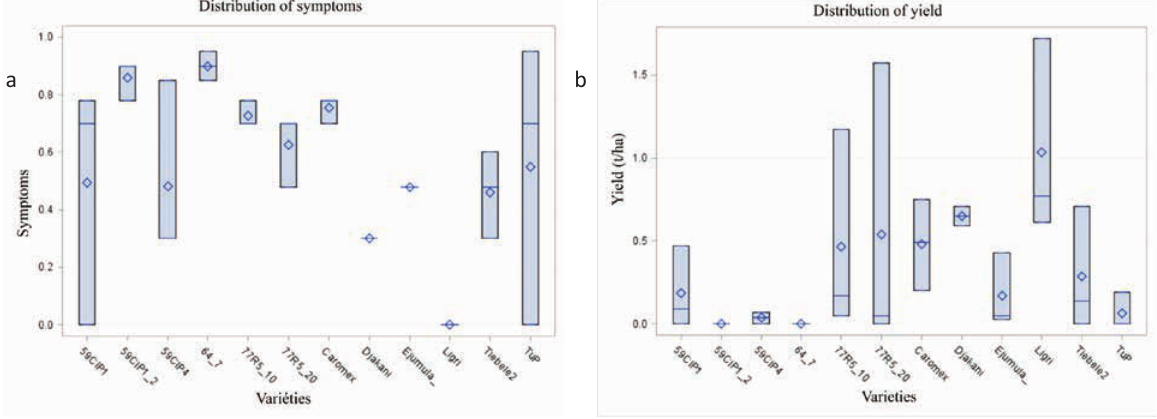
Figure 2: Symptoms and root yield distribution according to varieties